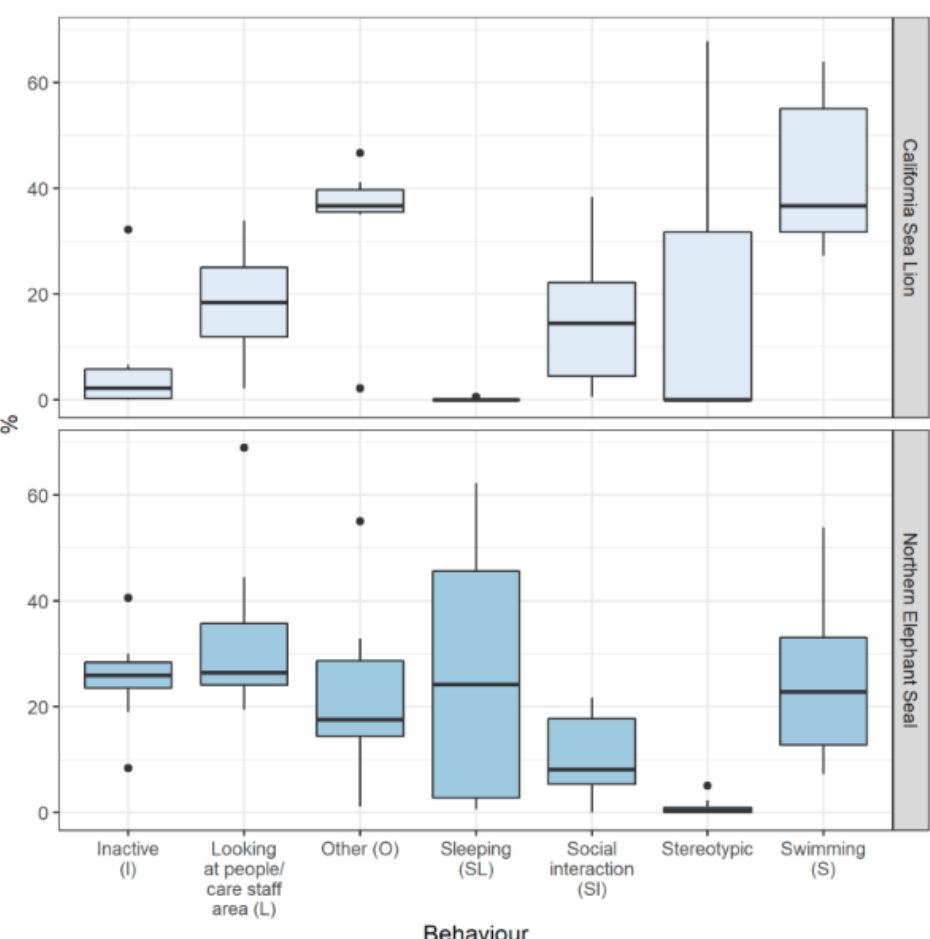
Figure 2. Boxplots describing medians, first quartile, third quartile (bars) and maxima and minima (whiskers) of observed percentages of exhibited behaviors by California sea lions and northern elephant seals during baseline observations. Black dots highlight outliers.